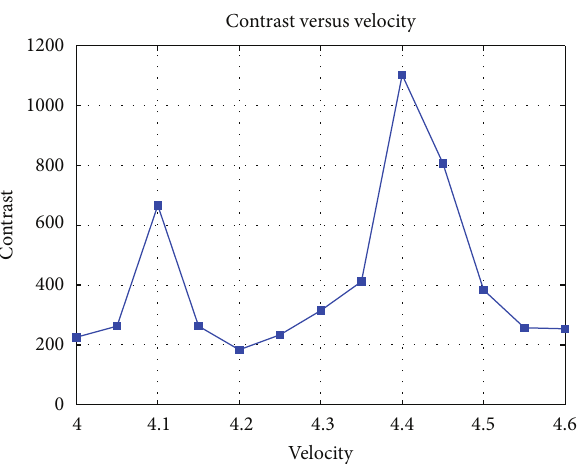
Contrast versus velocity